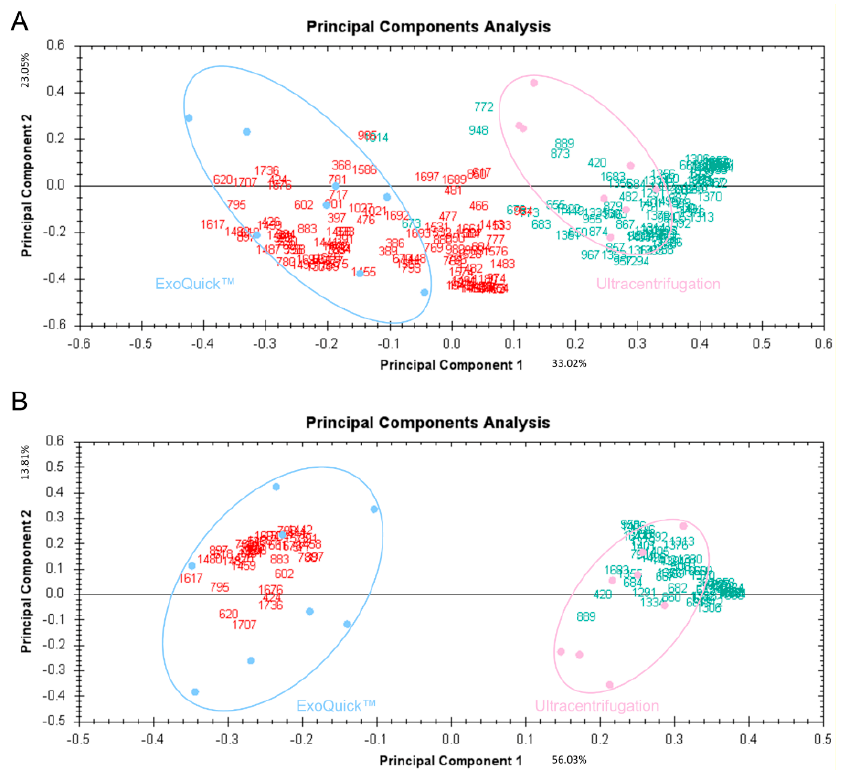
Commented [M2]: Figure 2 and figure title are new one.